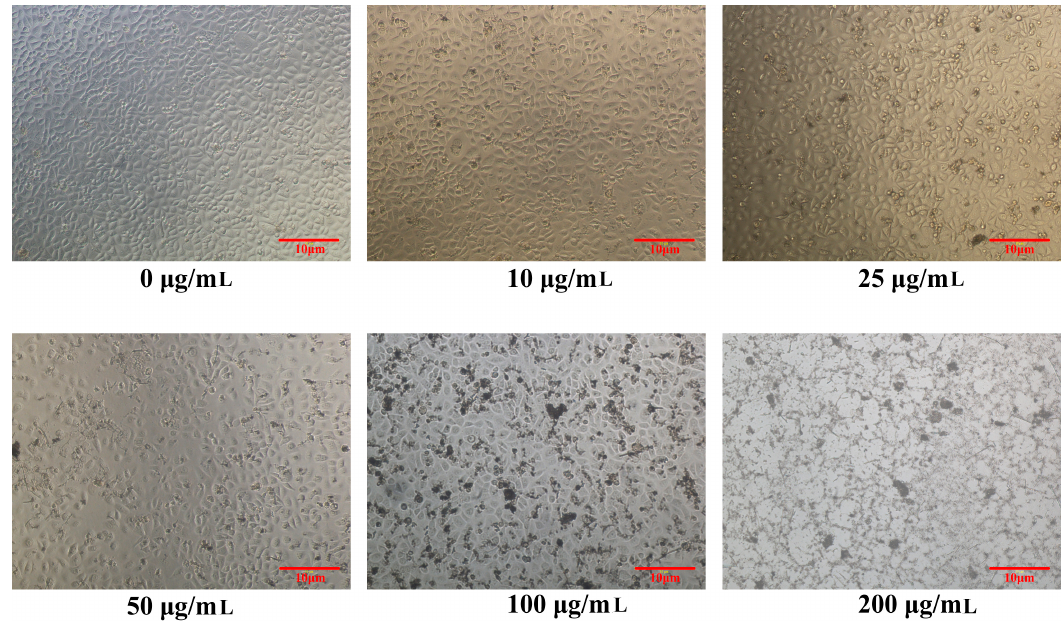
Figure 1. Morphology of human keratinocyte cell line (HaCaT) cells after being exposed to 0, 10, 25, 50, 100, and 200 μ g/mL PM 2.5 , respectively. Scale bar: 10 μ m.